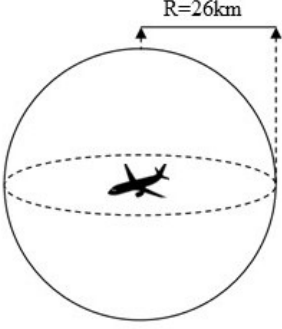
Figure 1. Near position detection area.